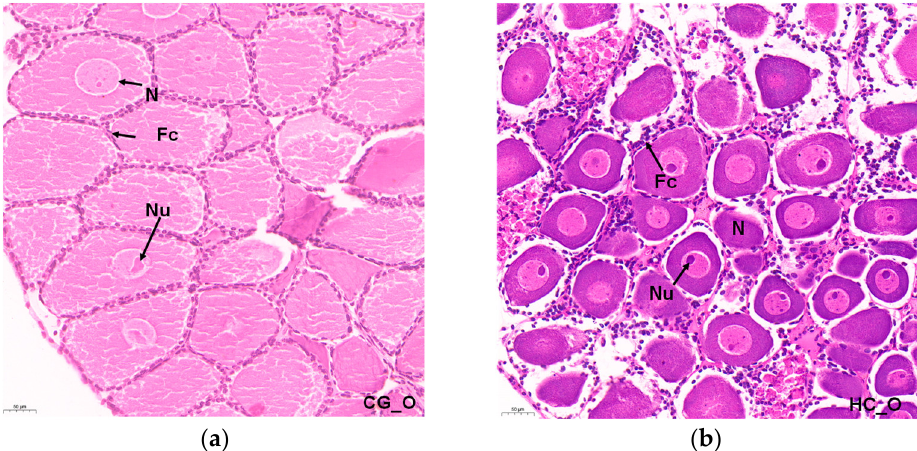
Figure 1. Histological sections of the ovarian status of E. carinicauda : ( a ) CG_O group; ( b ) HC_O group. Bar: 50 µm. N: nucleus; Nu: nucleolus; Fc: follicular cell.